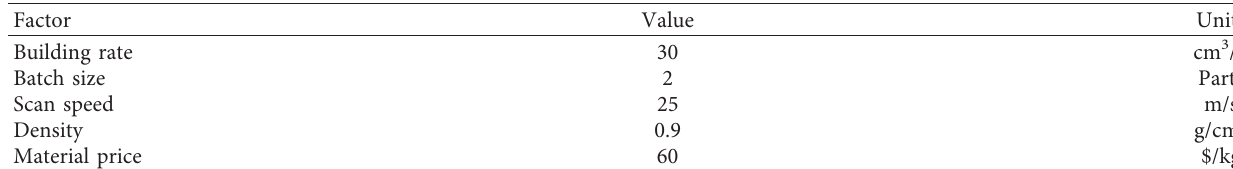
Table 9: The constant factors.